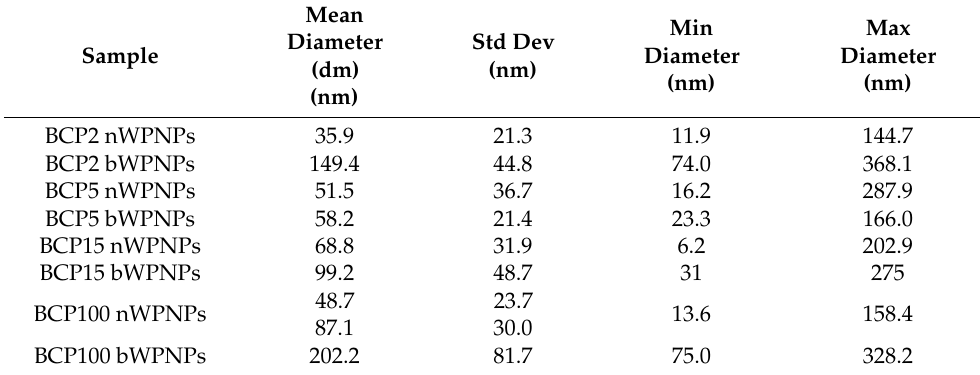
Table 4. Comparison of WPNP size, measured through TEM.